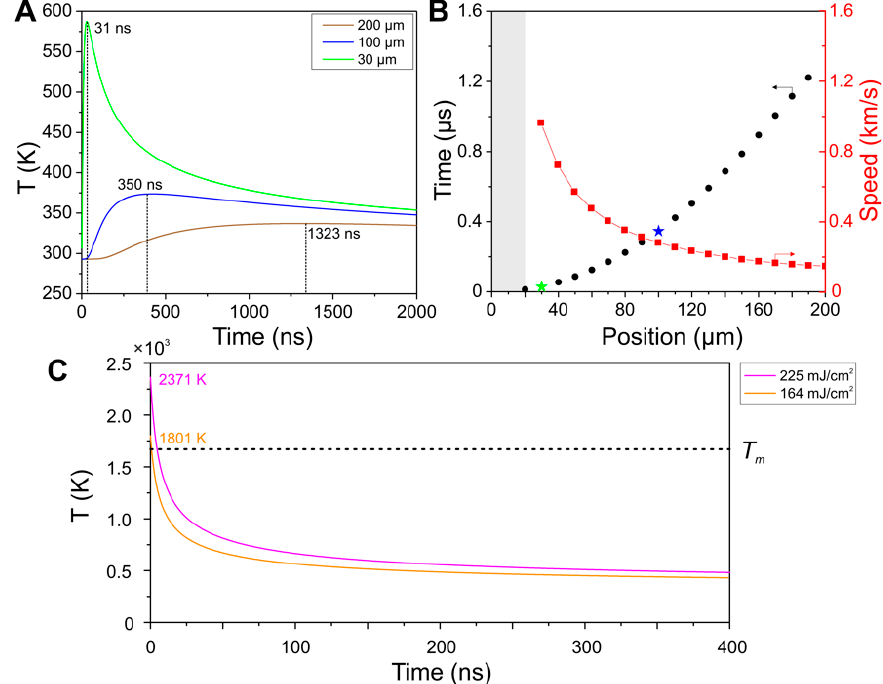
Figure 3. ( A ) Temperature curves in static probe mode evolving over time for a single laser pulse ϕ th = 164 mJ/cm 2 arriving at different positions x (30, 100 and 200 µ m) and sensed by the temperature probe fixed at x = 0 µ m. The inset numbers indicate the time that took the laser-deposited heat to reach the position of the probe and register the peak temperature; ( B ) Time that takes the heat to travel to a position x = 0 µ m vs the position where the laser pulse impinged on the bar. The times for positions 30, 100 and 200 µ m from ( A ) are plotted as green, blue and gold star symbols, respectively. The additional axis at the right represents the speeds (x/t, in km/s) at which the temperature maxima are being detected. The shaded area corresponds to the position of the beam waist, for which times were not measured. Data plotted on black circles use the Time ( µ s) axis, whereas data on red squares and red dashed line use the Speed (km/s) axis, as indicated by the small inset arrows; ( C ). Simulation of a single pulse impinging on the position of the temperature probe ( x = 0 µ m) with fluences φ = 225 mJ/cm 2 and 164 mJ/cm 2 without considering phase transformation effects. The maximum temperatures registered are 2371 K and 1801 K, respectively. The dash line at 1672 K corresponds to the melting temperature for steel.